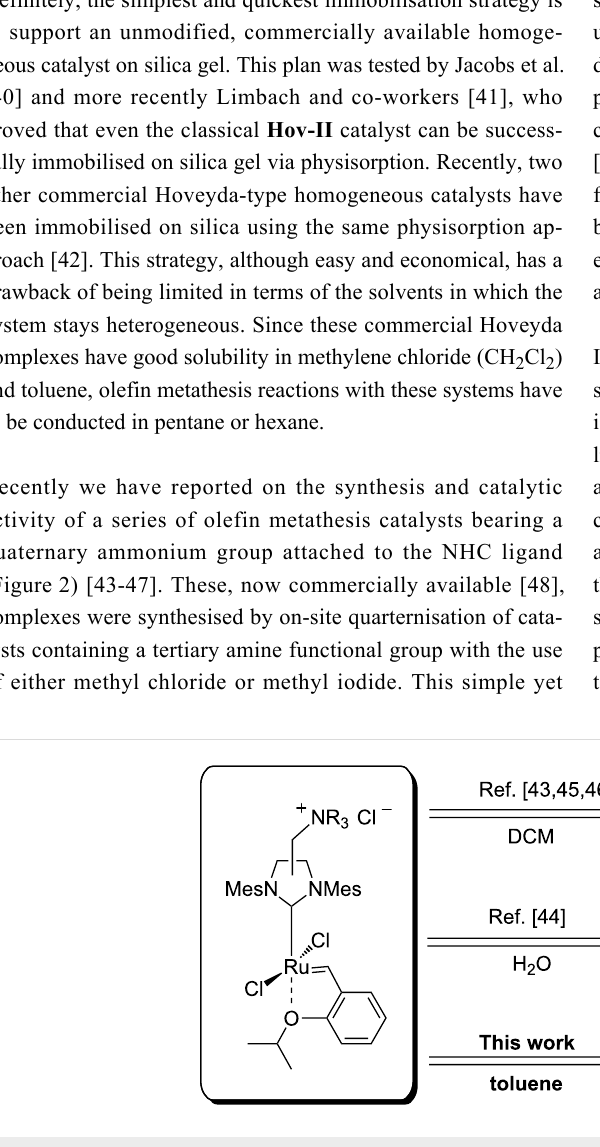
ligands dissociate during the catalytic cycle and as a result the active species containing heavy metal are leaching to the solu-